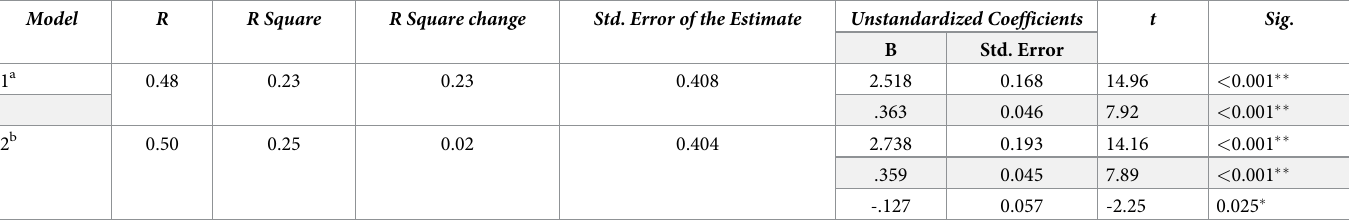
Table 5. Multiple linear regression analysis (stepwise regression) for job security predictors.